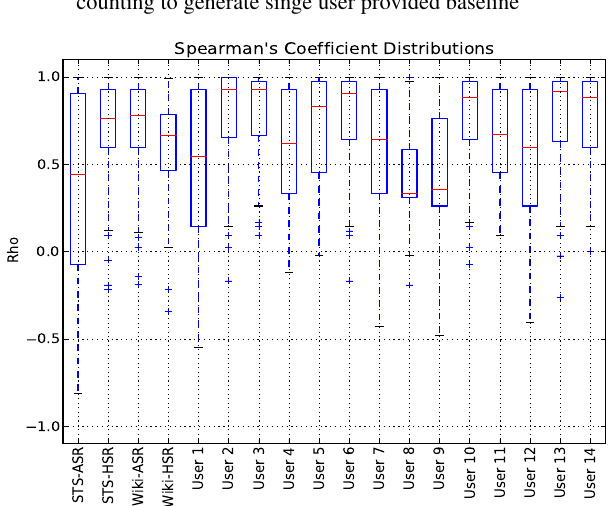
Figure 6: Summary of the distribution of ρ between user generated baseline and service rankings of individual algorithms and subjects subjects demonstrate a strong positive correlation with the